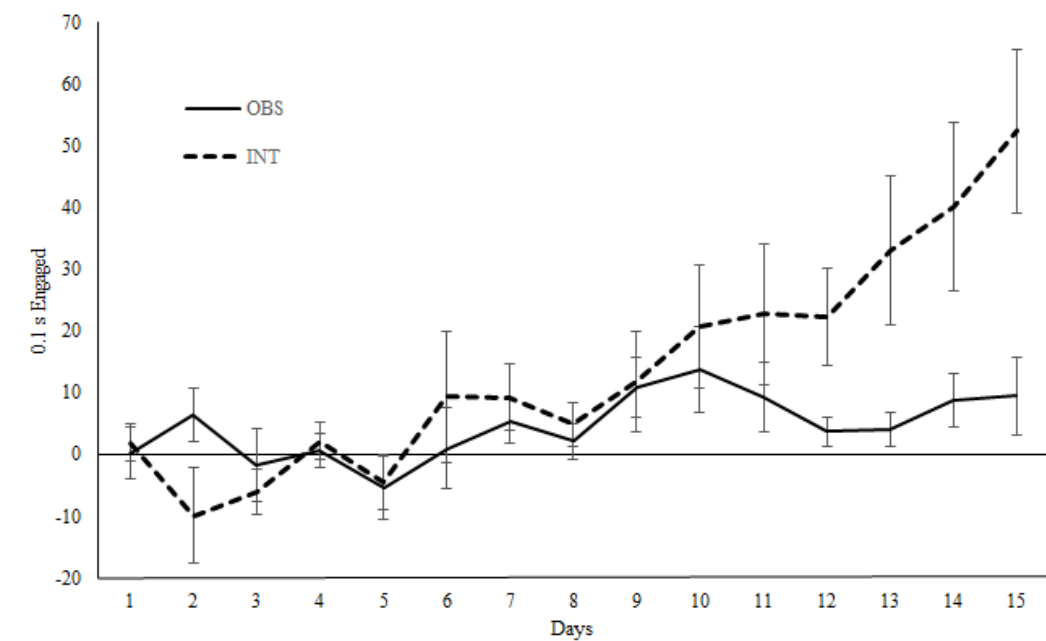
Figure A3 . The stimulus — pre-stimulus difference in presence on the near platform in Experiment 3 over